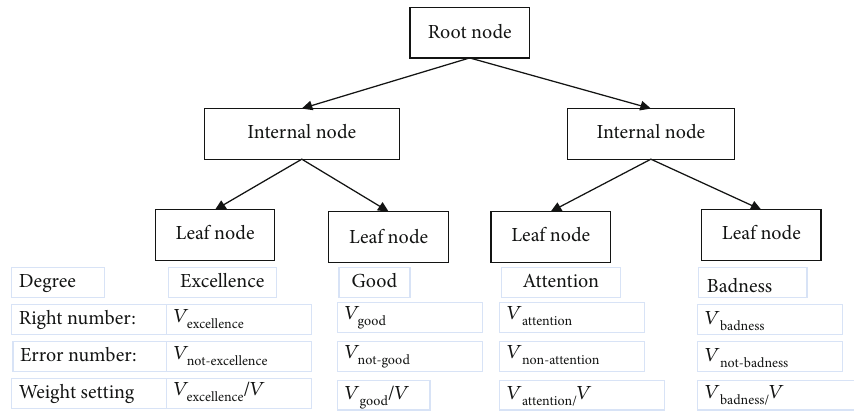
Figure 2: The setting of voting weight for improved random